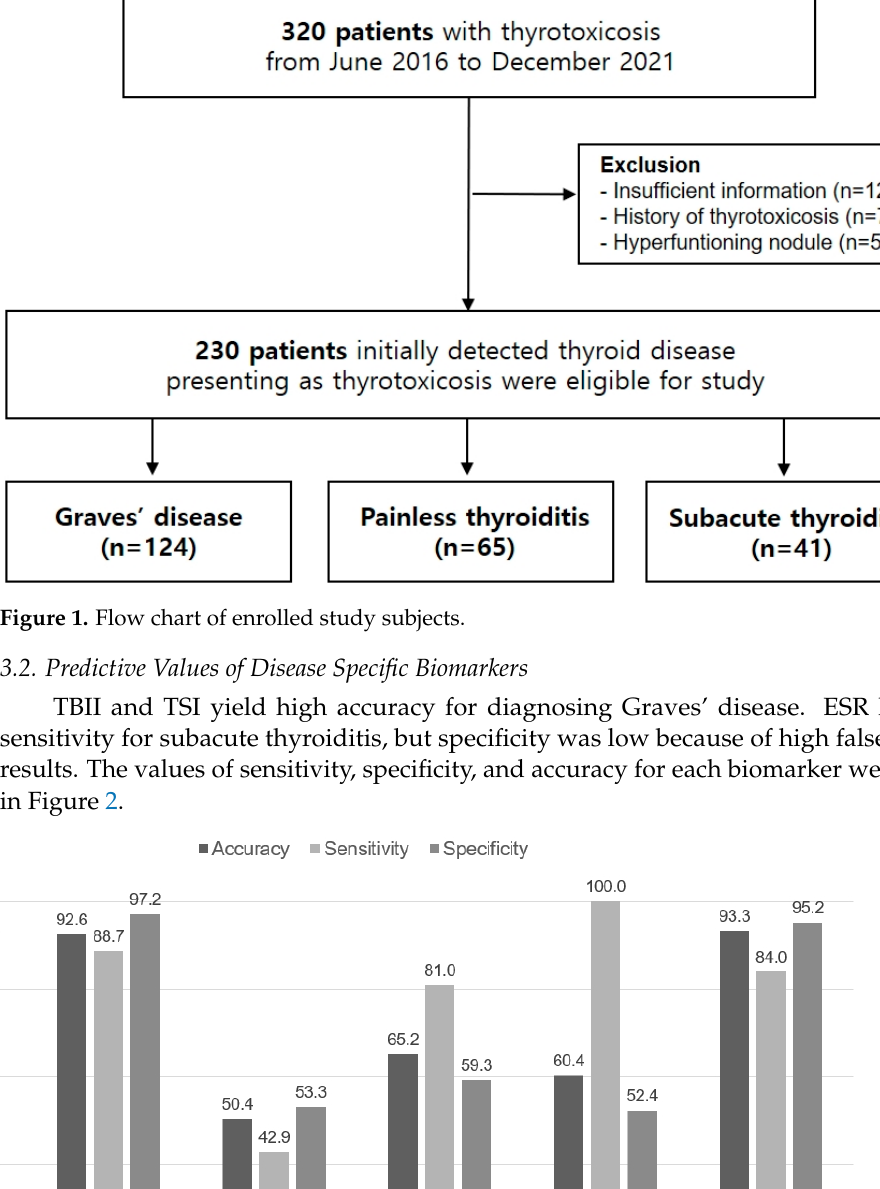
Table 2. Predicted value according to machine learning algorithm using initial blood test results (Model 1) and including thyroid antibody test results (Model 2).